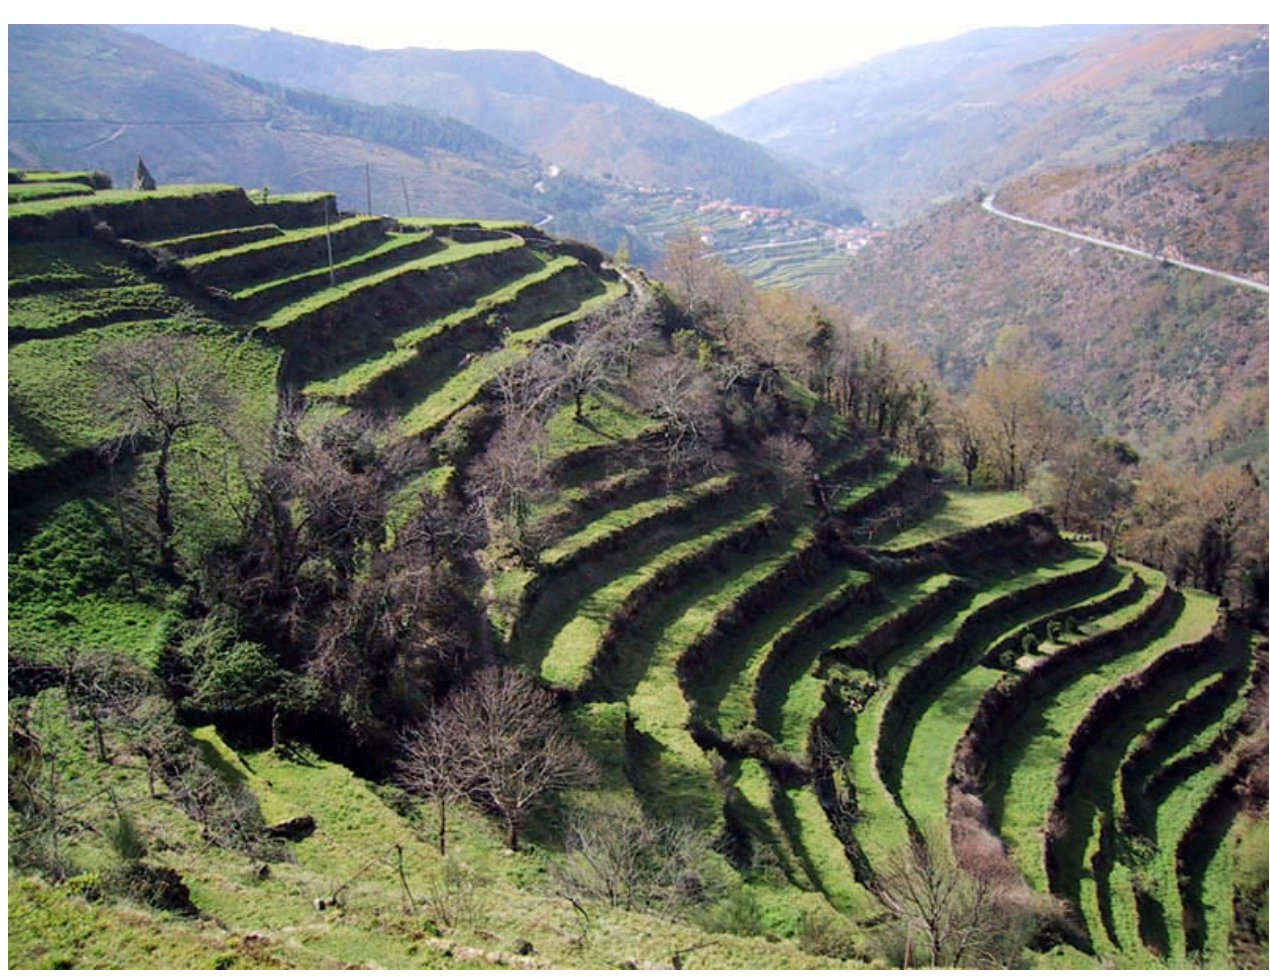
Fig. 3 . The agricultural terraces or socalcos of